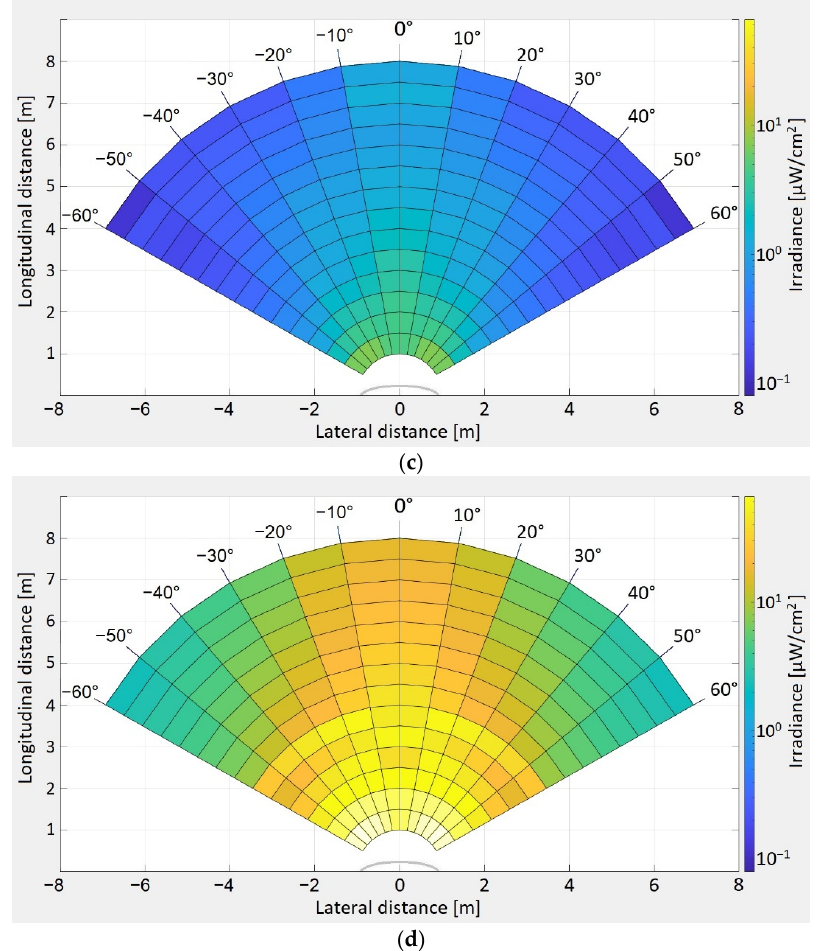
Figure 5. ( a ) Taillight irradiance distribution pattern for a vehicle with an LED-based lighting system; ( b ) stoplight irradiance distribution pattern for vehicle with an LED-based lighting system; ( c ) taillight irradiance distribution pattern for vehicle with incandescent based lighting system; and ( d ) stoplight irradiance distribution pattern for vehicle with incandescent based lighting system.